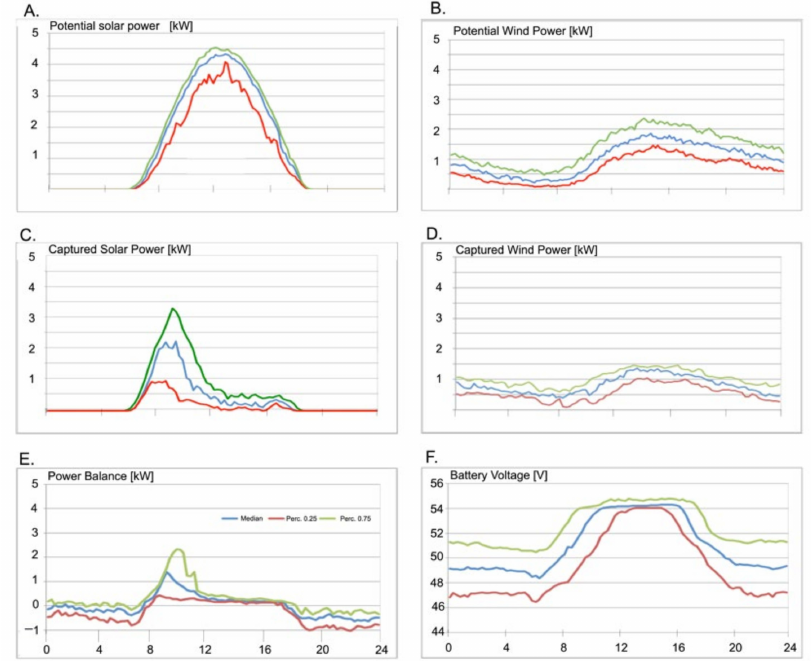
Figure 7. ( A ): Hourly profiles of potential solar power; ( B ): Hourly profiles of potential wind power; ( C ): Hourly profiles of captured solar power; ( D ): Hourly profiles of captured wind power; ( E ): Hourly profiles of power balance; ( F ): Hourly profiles of battery